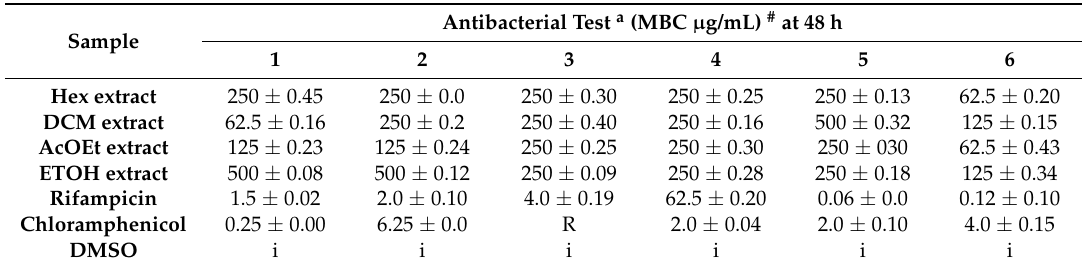
Table 3. Minimum bactericidal concentration of extracts from E. coccineum